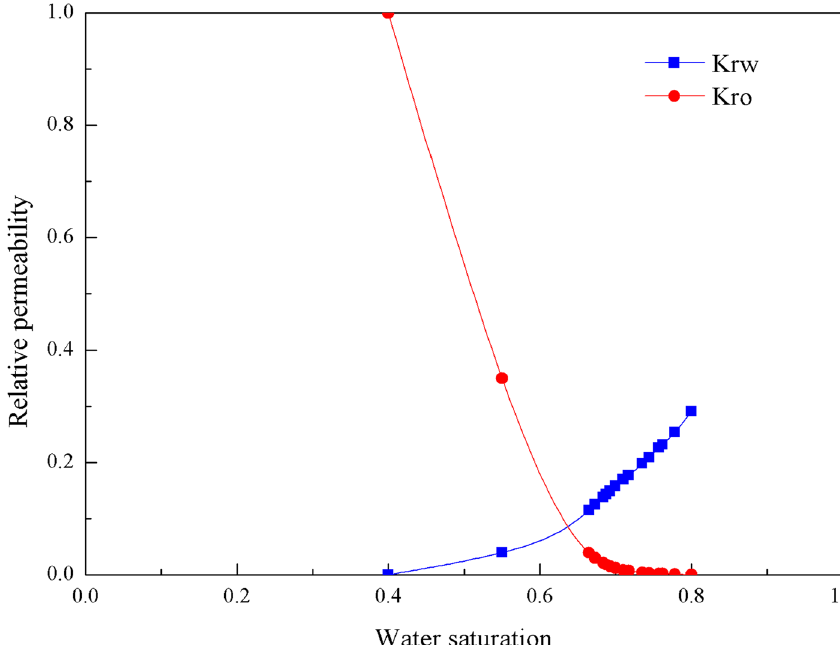
Fig. 1 Typical relative perme- ability curve of low-permeabil- ity